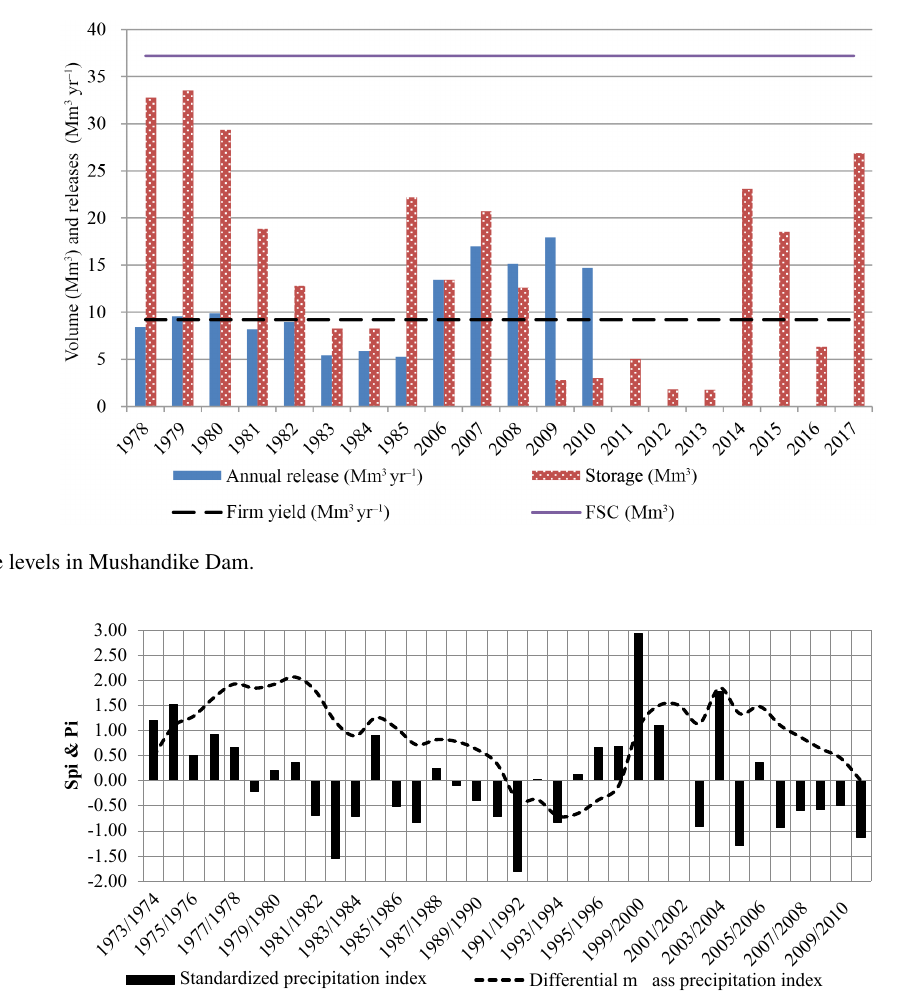
Figure 6. Cyclic changes on observed Rainfall